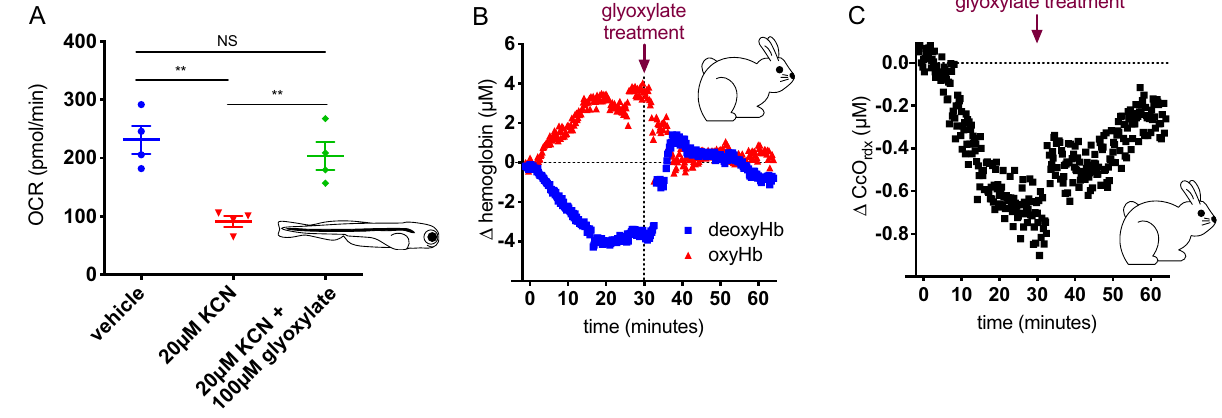
Figure 3. Oxygen metabolism is restored following glyoxylate treatment. ( A ) Oxygen consumption rates of 5 dpf zebrafish treated with DMSO, KCN, or KCN and glyoxylate with the given concentrations (**p < 0.005 using one-way ANOVA). Fish were arrayed 1 per well, N = 4 wells for each condition. ( B ) Glyoxylate was given i.m. to rabbits 30 min after exposure to i.v. cyanide, and deoxygenated and oxygenated hemoglobin were monitored throughout the timecourse with diffuse optical spectroscopy (DOS). Data from a single representative rabbit are shown. ( C ) DOS monitoring of cytochrome C oxidase state. Glyoxylate was administered i.m. 30 min after i.v. cyanide infusion started. Results shown for a single rabbit are typical of the response seen by DOS in animals treated with cyanide and